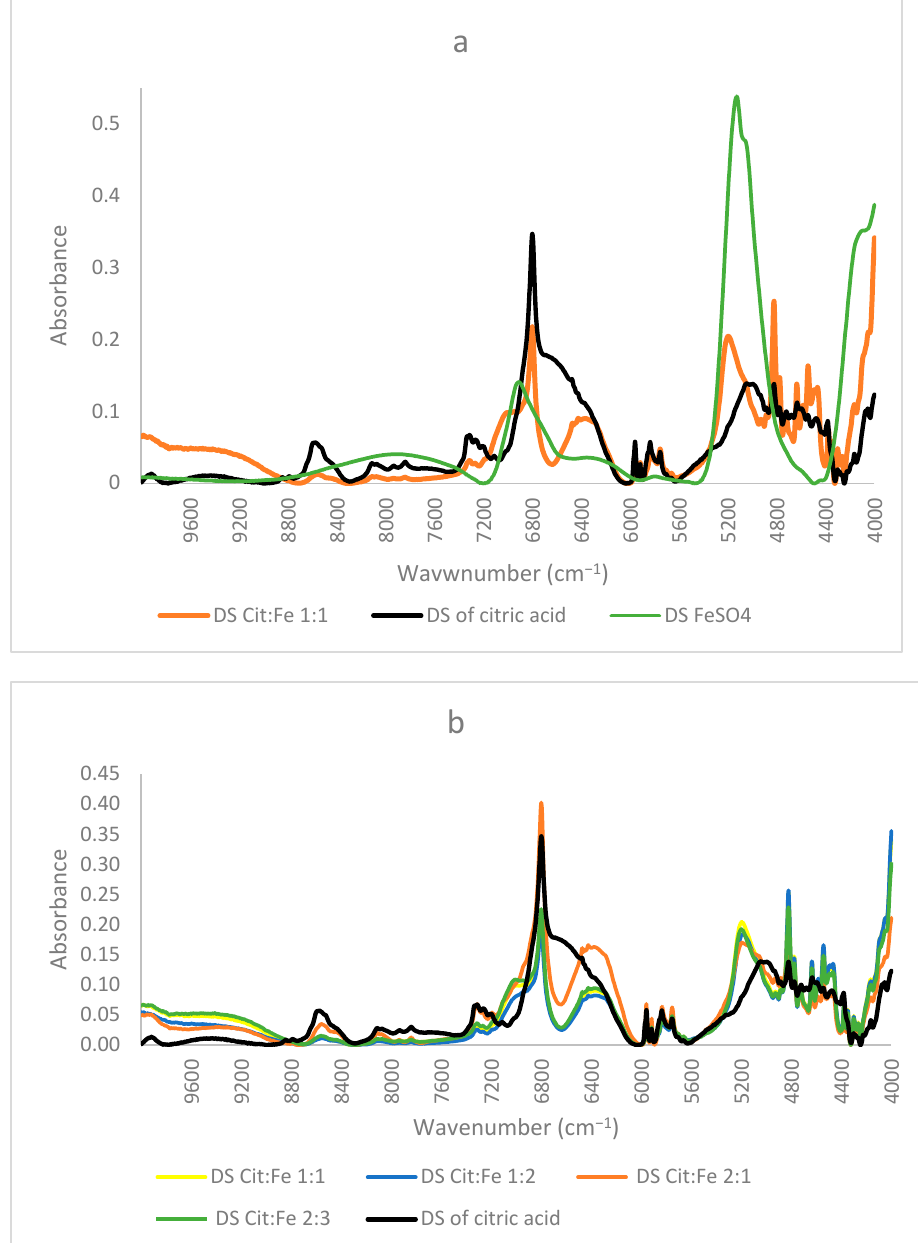
Figure 5. NIR spectra of dried solutions of ( a ) citric acid, iron sulfate, and citric:iron 1:1 sample; ( b ) the samples with different ratios .